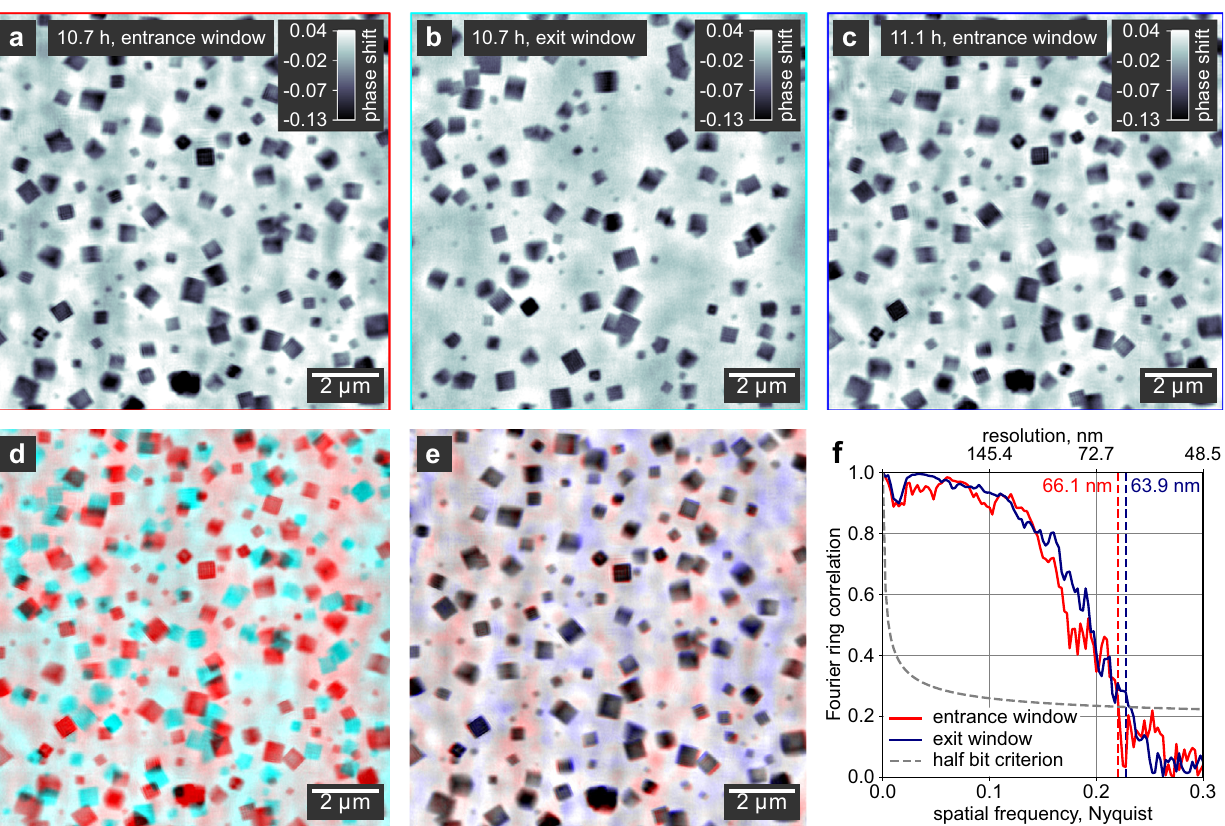
Fig. 2 | Quality estimation of in situ images. a , b Ptychographic images of particlesgrowingontheentranceandexitwindows,respectively,oftheinsitu reactor at the same reaction time. In b , the background fl uctuations are varying on larger scales compared to a due to the larger illumination size on the exit window. c Ptychographic image of the entrance window at a later reaction time compared to ( a , b ). The gray scale indicates the phase shift of the image in radian. d False-colored overlay of images of the entrance (red)